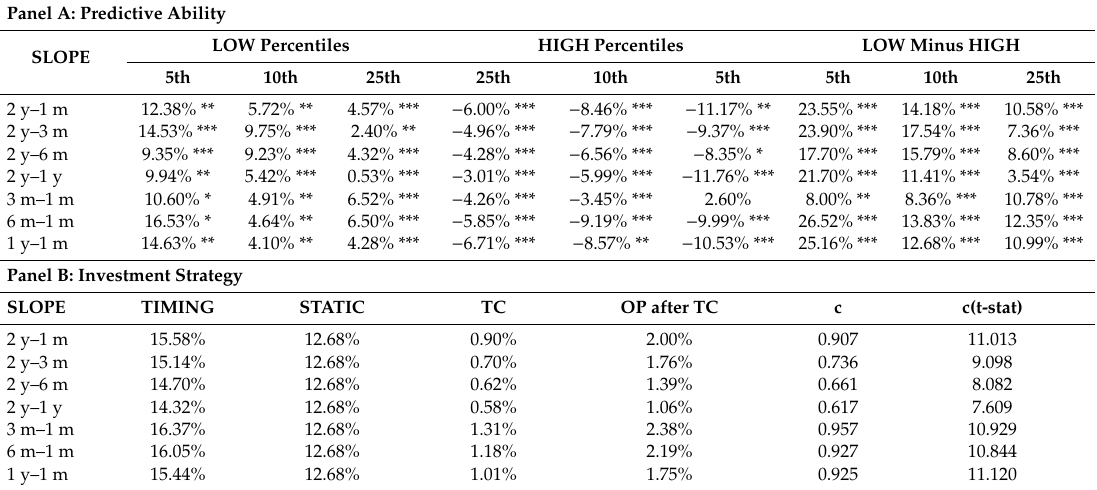
Table 6. Results from using di ff erent definitions of the slope of the equity